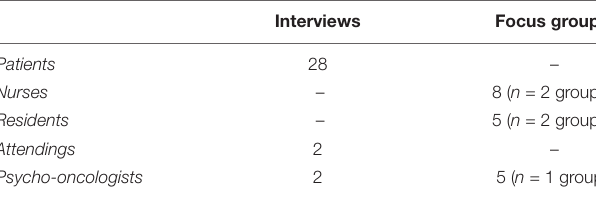
TABLE 2 | Overview of conducted interviews und focus groups